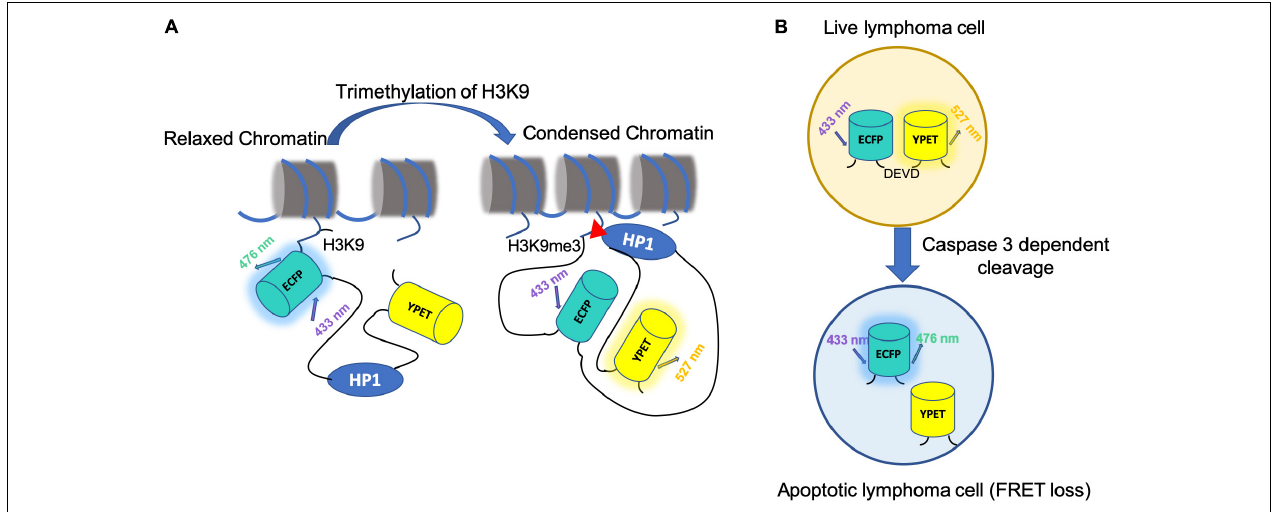
FIGURE 3 | Application of FRET biosensor in epigenetics and cancer treatment. (A) The mechanism of H3K9 tri-methylation FRET biosensor. The H3K9me3 tri-methylation biosensor consists of a full-length histone H3, an ECFP (donor FP), a flexible EV linker (120aa), a heterochromatin protein 1 domain (HP1), and a YPet (acceptor FP). At rest state, the H3K9me3 biosensor has an open conformation with low FRET. With H3K9me3 by an upstream methyltransferase, such as SUV39H1, HP1 binds to the tri-methylated H3K9, causing a strong FRET. (B) A schematic for using FRET to monitor cell apoptosis in vivo . FRET-based caspase-3 reporter is used in E µ -myc-DEVD malignant B cells. CFP and YFP are linked by the DEVD sequence, a caspase3 target sequence. Caspase-3 activity during apoptosis results in FRET